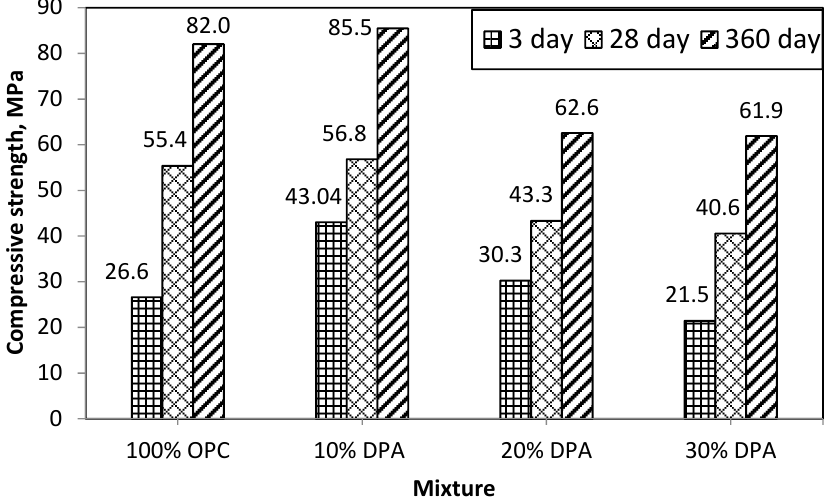
Figure 3. Compressive strength development in mortar mixtures.